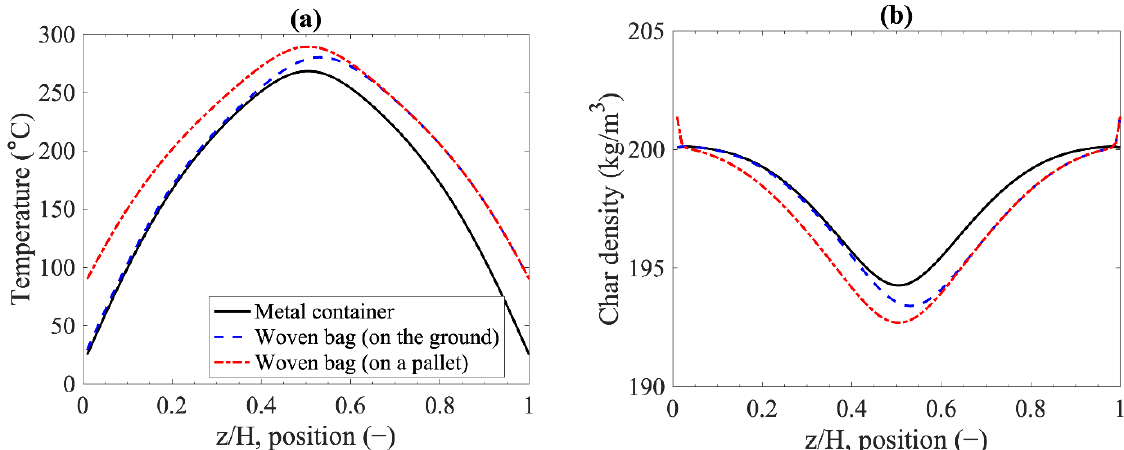
Figure 10. Local profiles inside the storage container after 12 h (storage condition: T 0 = 210 ◦ C, T ambient = 25 ◦ C, ρ c ,0 = 200 kg m − 3 , and H container = 1 m): ( a ) char temperature; ( b ) char density.